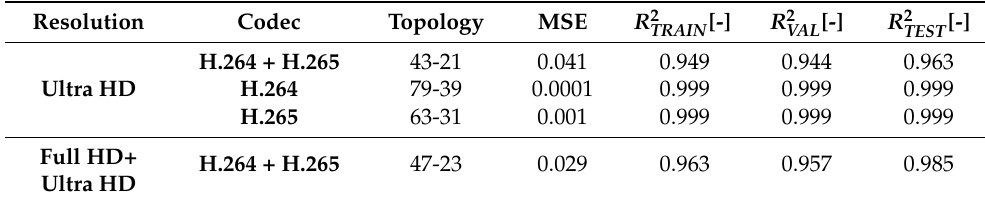
Table 6. Simulation of bitrate prediction based on SSIM for the best topologies.